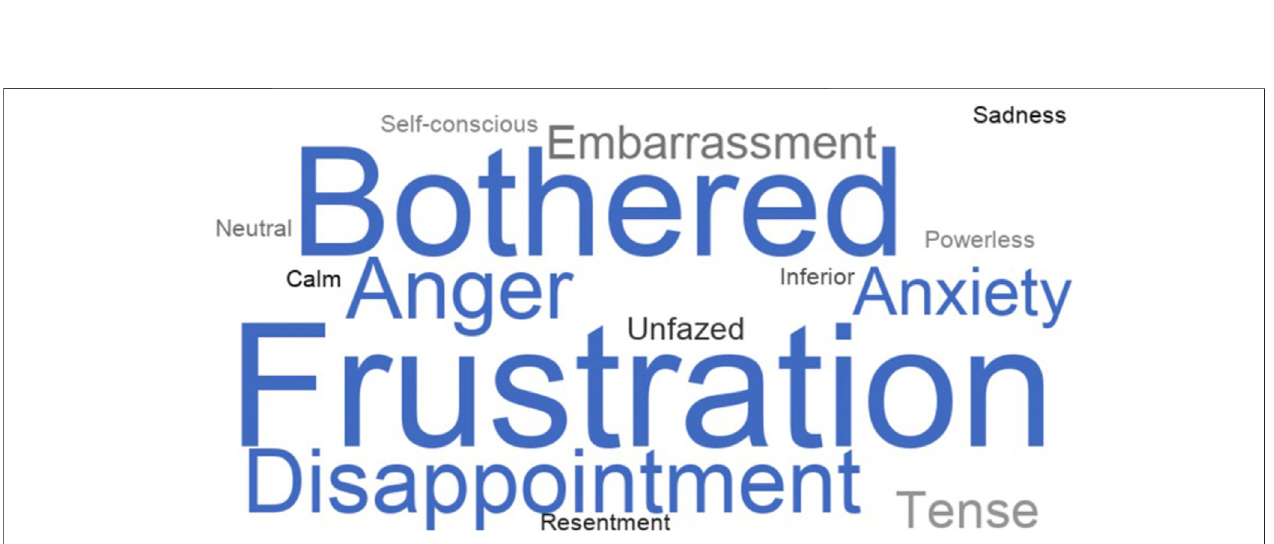
Frontiers in Arti fi cial Intelligence |